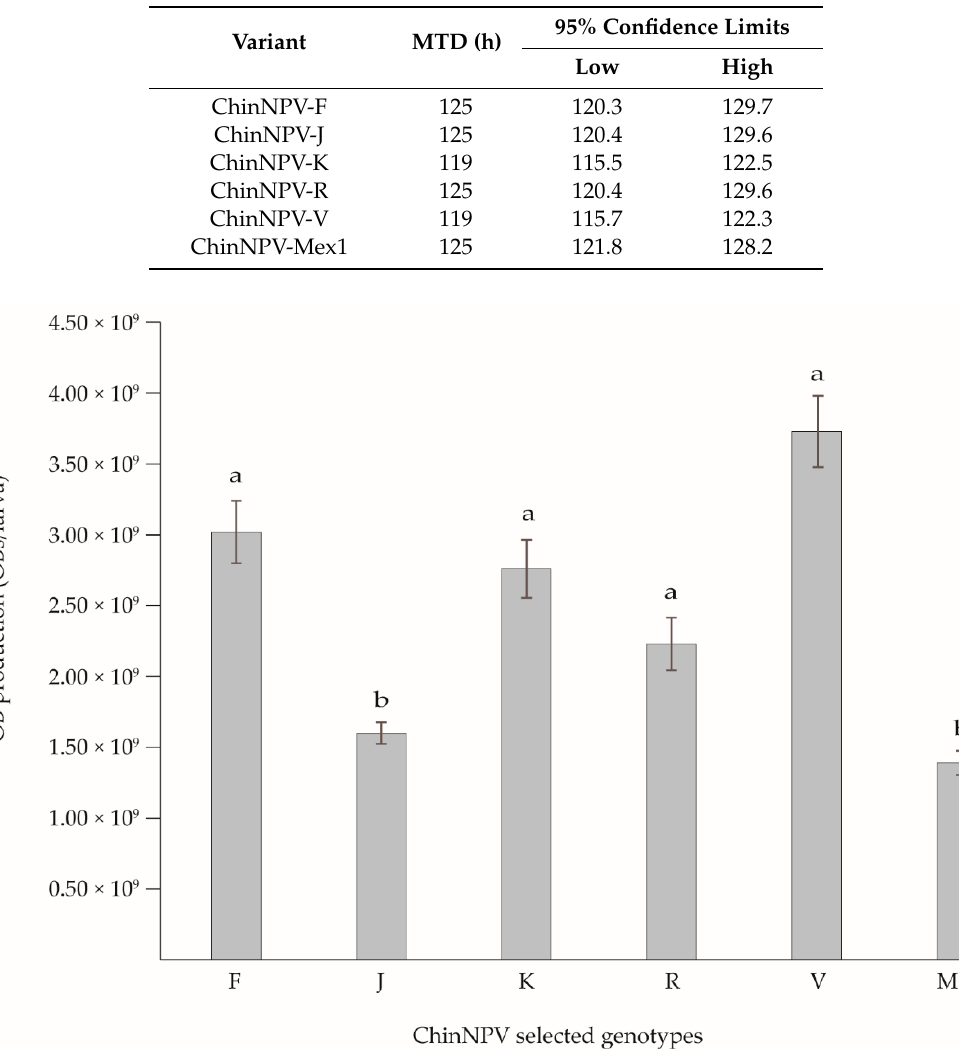
Table 3. MTD values of genotypic variants estimated in C. includens second instars.